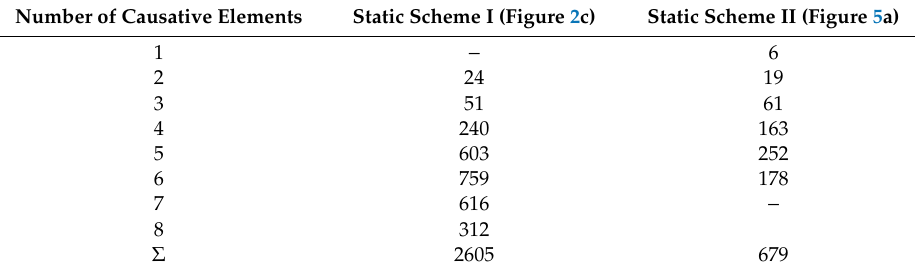
Table 3. Kinematically admissible failure mechanisms for truss “B”. Static Scheme I (Figure 2c) Static Scheme II (Figure 5a)